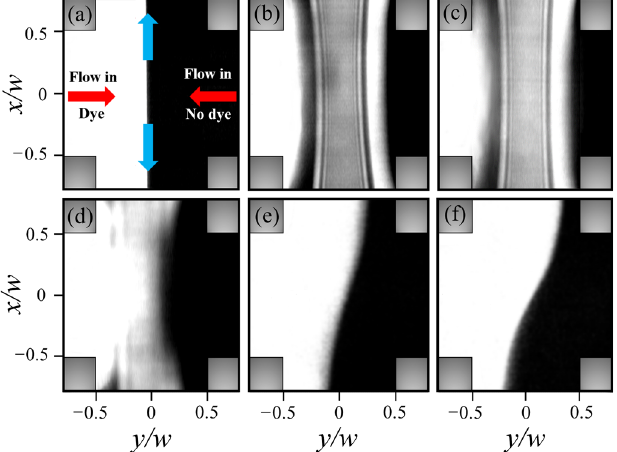
FIG. 3. Confocal microscope images of dye-advection patterns taken in the x - y center plane ( z ¼ 0 plane) of the cross-slot device for aqueous PEO solutions of various El. Fluid dyed with rhodamine B enters from the left-hand inlet channel and undyed fluid enters through the right-hand inlet channel. (a) Stable flow with a symmetric interface (Newtonian or viscoelastic, Re < 10 ). (b) Inertial instability of Newtonian fluid (El ¼ 0 , Re ¼ 80 ). (c) Inertioelastic instability with 0.001 wt % PEO solution (El ¼ 0 . 00018 , Re ¼ 79 ). (d) Inertioelastic instability with 0.01 wt % PEO solution (El ¼ 0 . 011 , Re ¼ 33 ). (e) Elastic instability with 0.1 wt % PEO solution (El ¼ 0 . 68 , Re ¼ 49 ). (f) Elastic instability with 0.3 wt % PEO solution (El ¼ 10 . 4 , Re ¼ 15 ). See also the video corresponding to (f) contained in the Supplemental Material